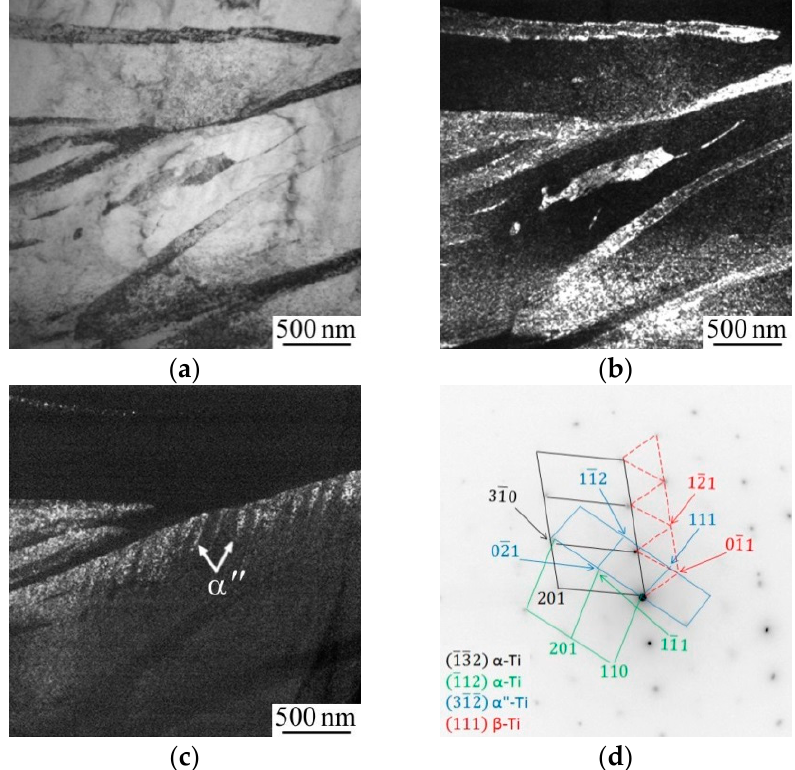
Figure 9. Bright- ( a ) and dark-field TEM micrographs ( b , c ), and the associated SAED pattern with indexing scheme ( d ) of the microstructures of the EBAM Ti-6Al-4V samples produced with substrate cooling. The dark-field TEM micrographs were obtained with the 111(cid:3435)132(cid:3439) α -Ti and 110(cid:4666)111(cid:4667) β -Ti (b), 0 21(cid:3435)312(cid:3439) α ʹʹ -Ti and 111(cid:3435)112(cid:3439) α -Ti reflections ( c ). The microstructure was obtained at a distance of 40 mm from the substrate.